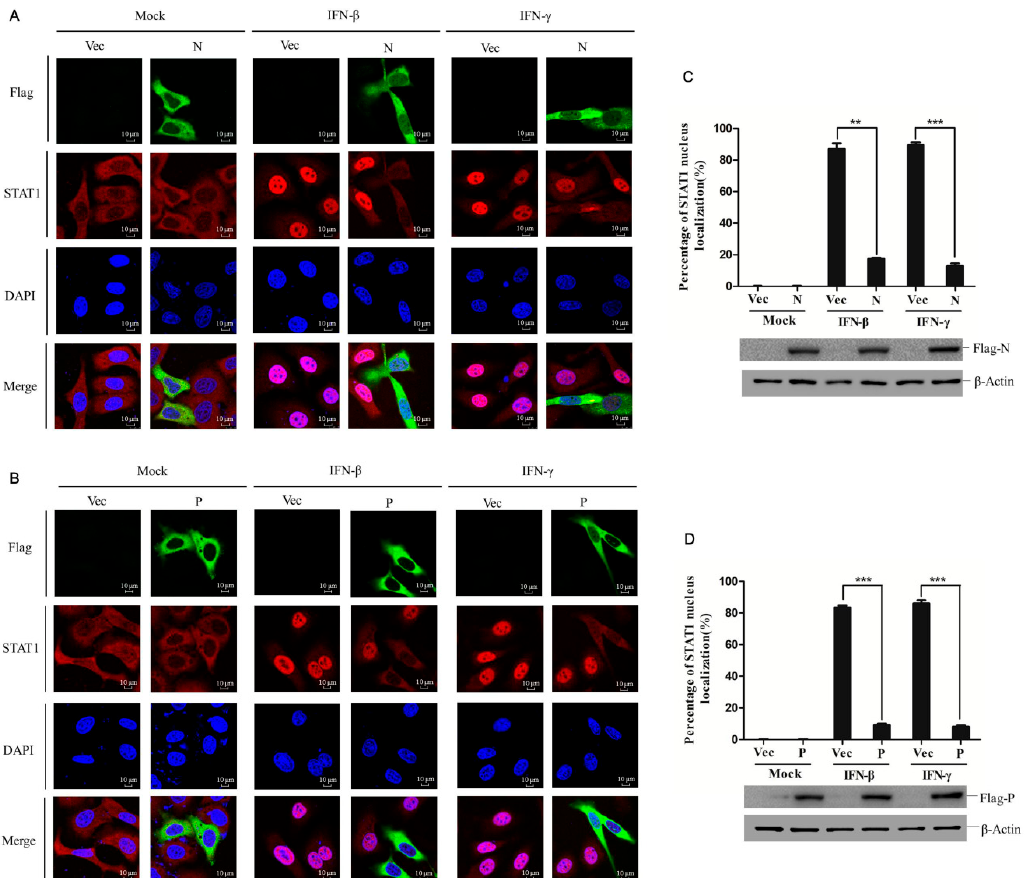
Figure 3. PPRV N and P proteins inhibited STAT1 nuclear translocation. ( A and B ) HeLa cells (5 × 10 4 ) were grown in the glass bottom dish. When the cells reached about 30% confluency, the cells were transfected with N protein expressing plasmids (2 μ g), P protein expressing plasmids (2 μ g) or vector plasmids (2 μ g), followed by IFN- β (2000 U/mL) or IFN- γ (200 ng/mL) treatment for 30 min. The cells were fixed, permeabilized, and incubated with mouse anti-STAT1 antibody and rabbit anti-Flag antibody and appropriate secondary antibodies. The subcellular localization of STAT1 in N protein overexpressing cells ( A ) or P protein overexpressing cells ( B ) was observed (Red). Confocal images were obtained using laser confocal microscopy under a 60× objective. ( C ) Statistical analysis of STAT1 nuclear translocation in the N and P protein expressing cells. One hundred cells were counted in the randomly selected visual fields three times, and the STAT1 nuclear localization ratio was determined. The expression of N and P was further detected by Western blotting.